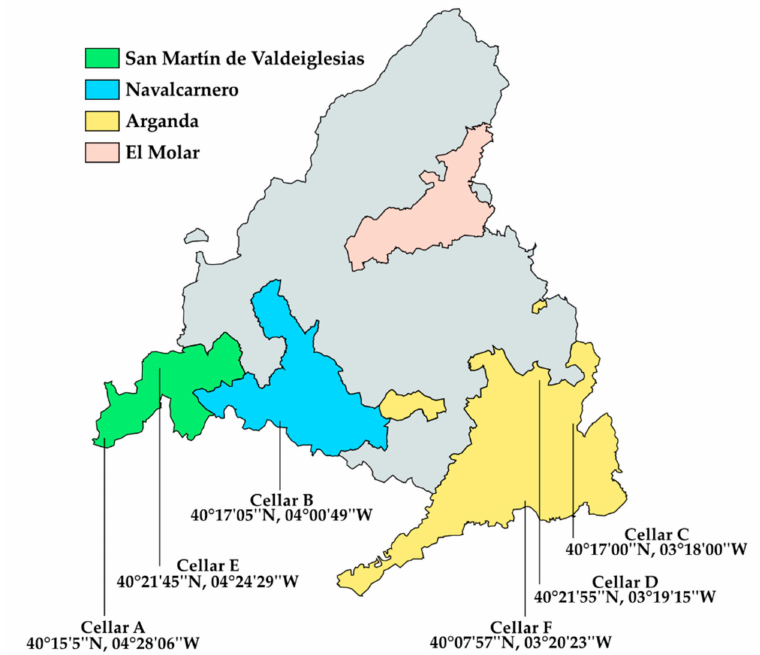
Figure 1. Map of D.O. “Vinos de Madrid”. Di ff erent regions and location of cellars (A-F) included